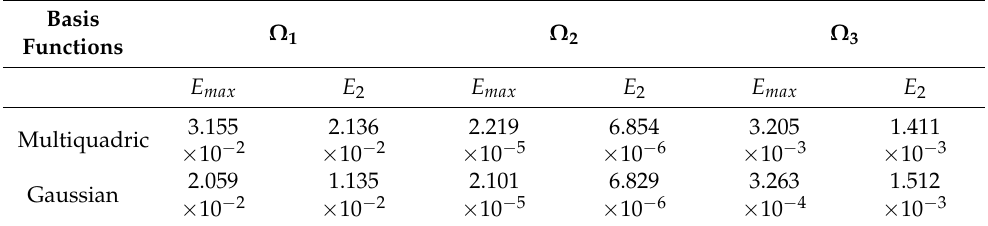
Table 1. E max and E 2 for the BSM method and the effect of the chosen basis function and domain at times T = 1 for Example 2 where τ = 0.06, α = 4, c = 5, ν = 2, γ = 0.5, K = 120, M = 209, K 1 = 90, N = 101.